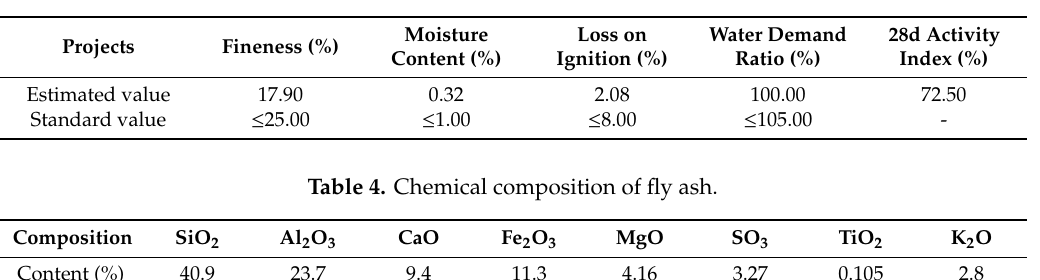
Table 3. Physical Indexes of Fly Ash.